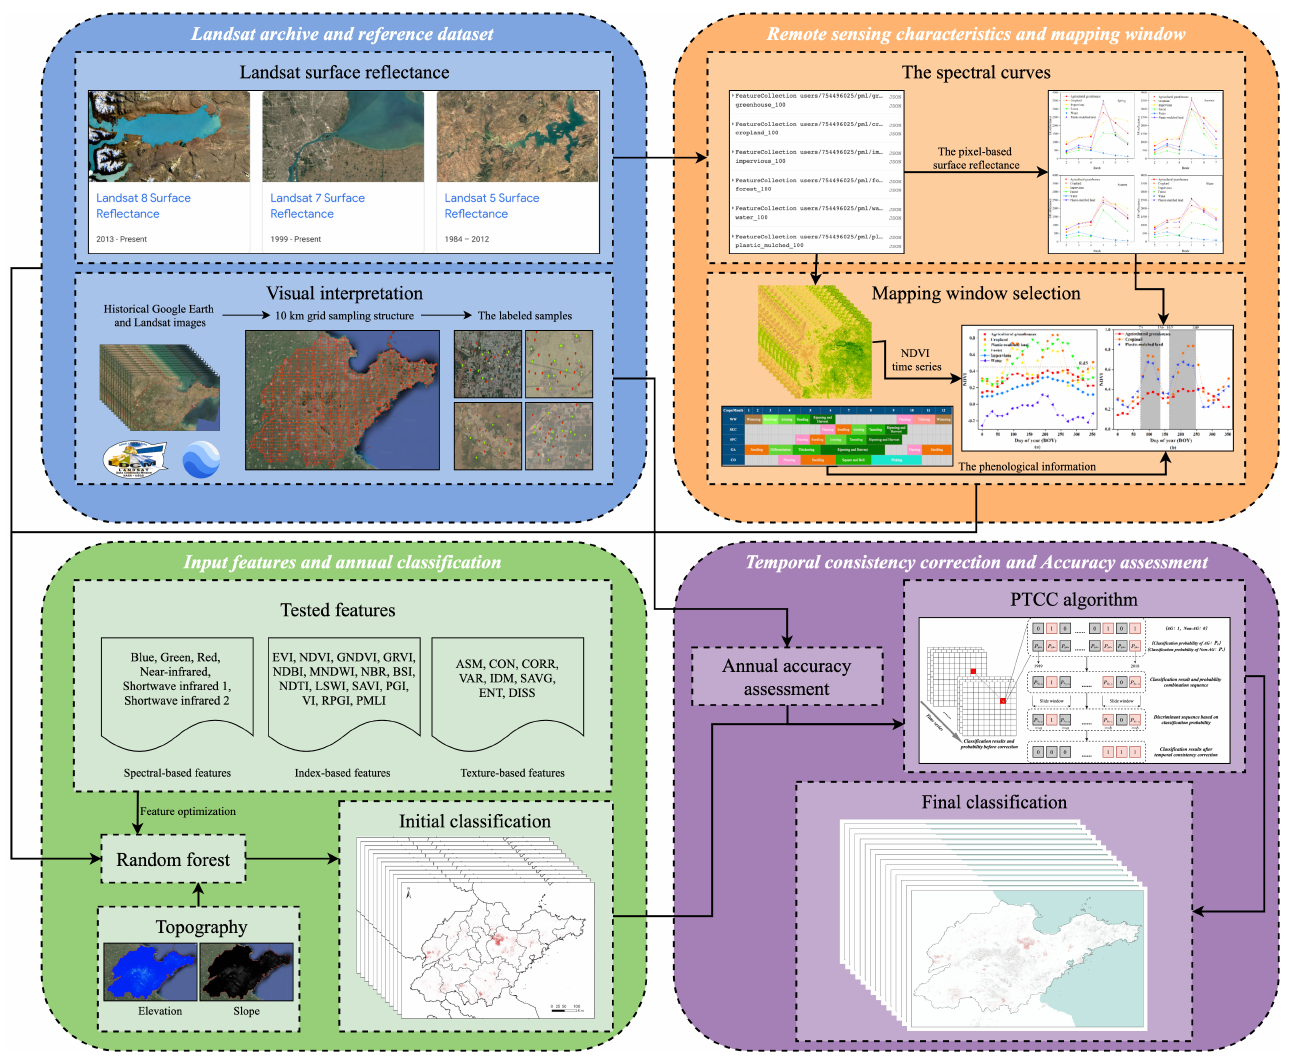
Figure 4. The research flowchart of the